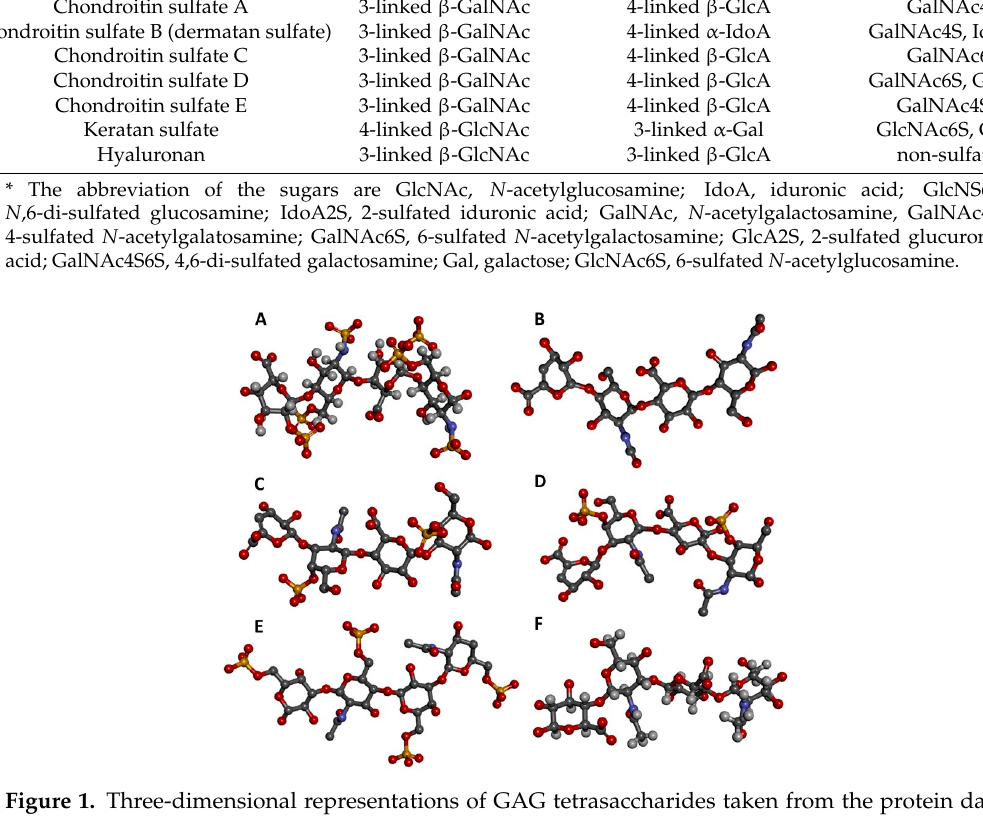
Figure 1. Three-dimensional representations of GAG tetrasaccharides taken from the protein data bank